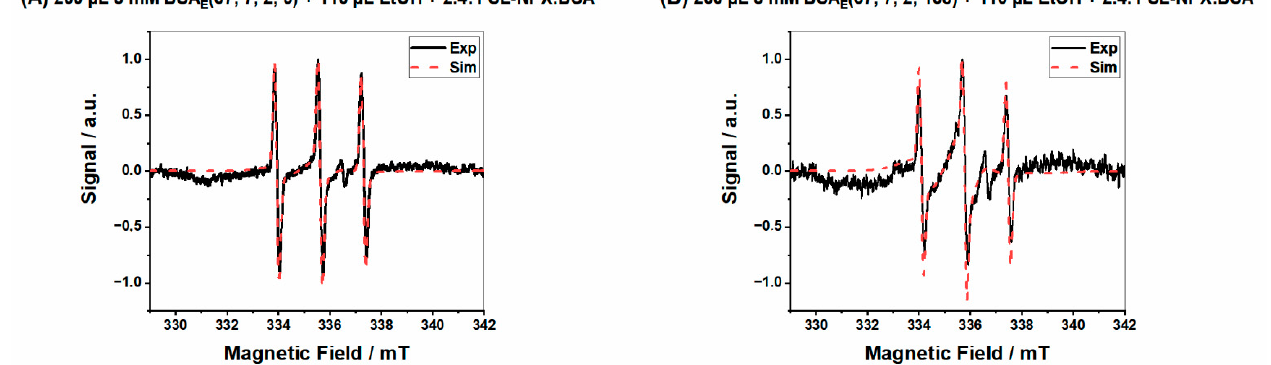
Figure 8. EPR spectra of release test for hydrogels prepared by 200 µL 5 mM BSA, 110 µL ethanol and 2.4:1 SL-NPX:BSA molar ratio of ( A ) BSA E (37, 7, 2, 9) and ( B ) BSA E (37, 7, 2, 168).